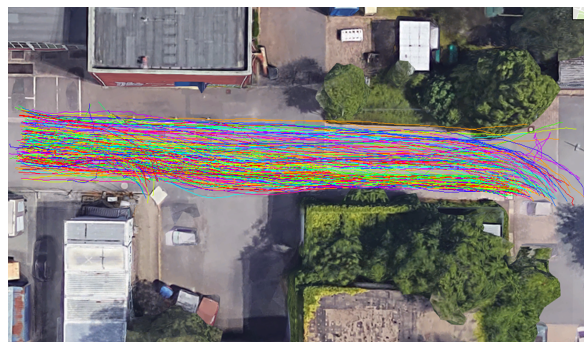
Figure 5. The trajectories of pedestrians are analyzed in our first experiment. The colors encode the different objects. (Basemap: imagery ©2019 Google, map data GeoBasis-DE/BKG ©2009) 38 of them only have a group size of 2 o 3 members, there are also 5 of size 4, 2 of size 5 and 6 as well as 1 of size 9.